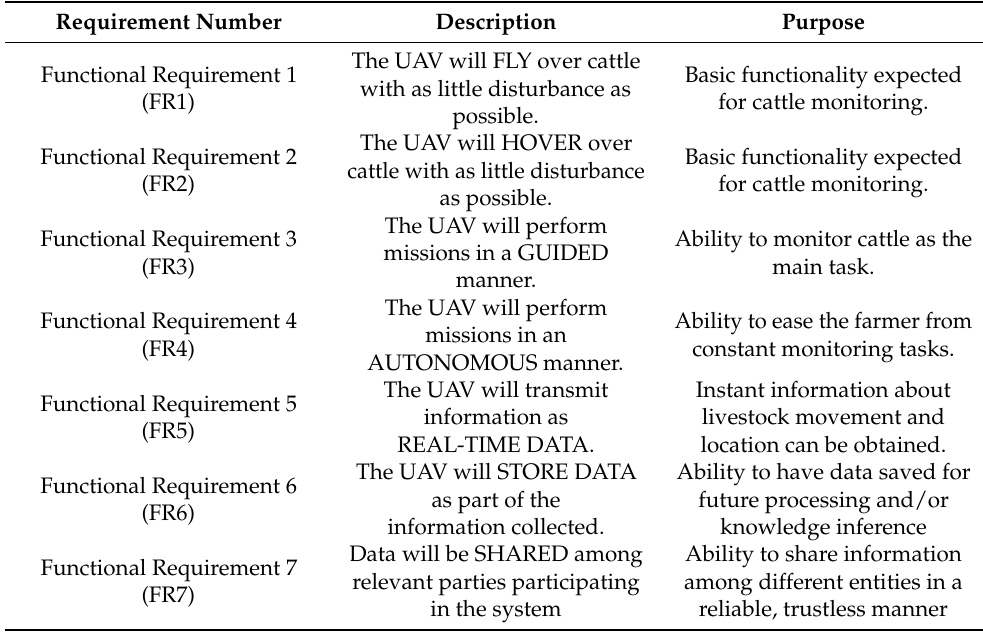
Table 4. List of the UAV functional requirements.